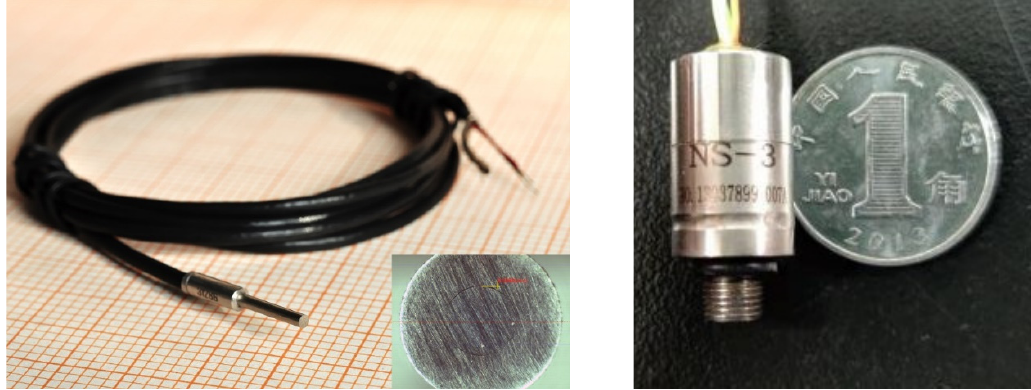
Figure 5. Type-E coaxial thermocouple heat flux sensor ( left ) and NS-3 pressure sensor ( right ). During the experiment, the driving section is filled with a 2:1:2 hydrogen, oxygen and nitrogen mixture at a pressure of 0.33 MPa. The air pressure in the driven section is